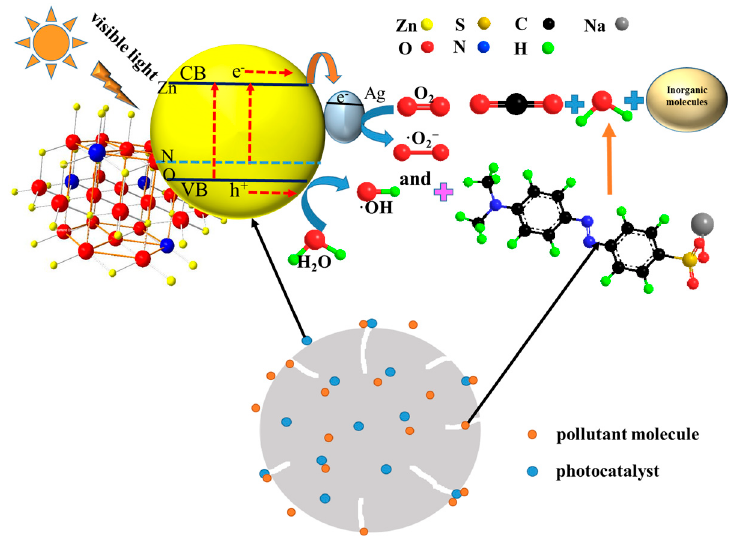
Figure 10. Mechanism for photocatalytic degradationaction of MO on the Ag-N-ZnO/AC photocatalyst.